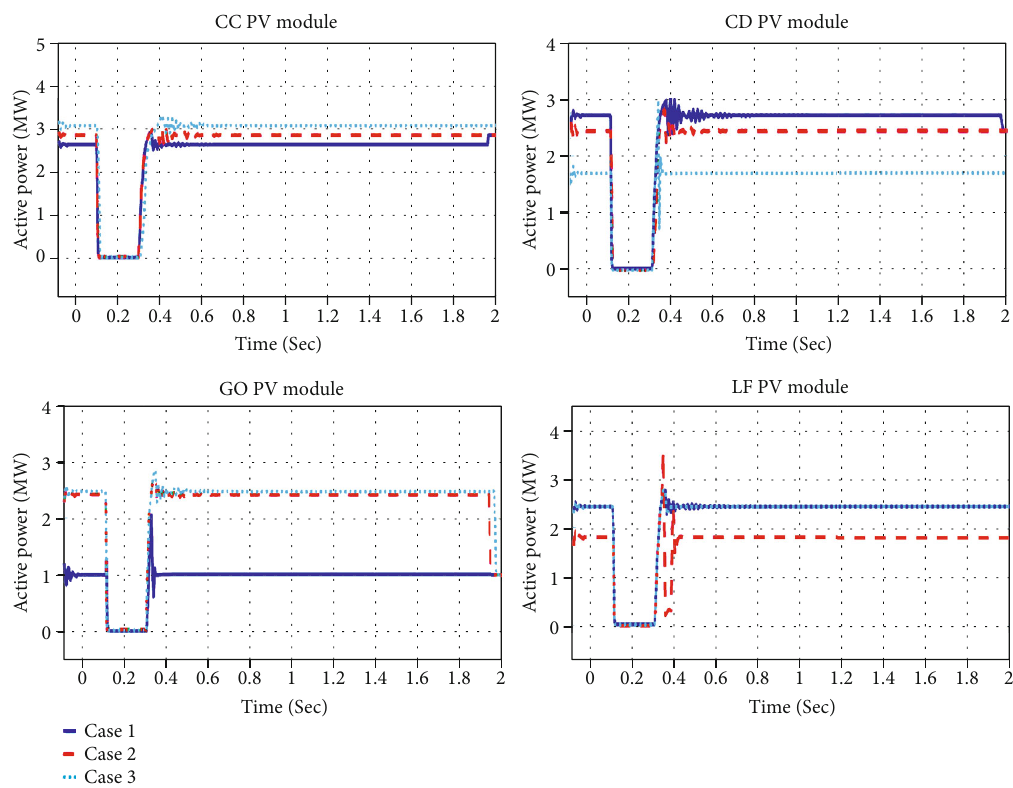
Figure 14: Active power from PV module according to the four dispatch strategies. This fi gure is reproduced from Shezan et al.